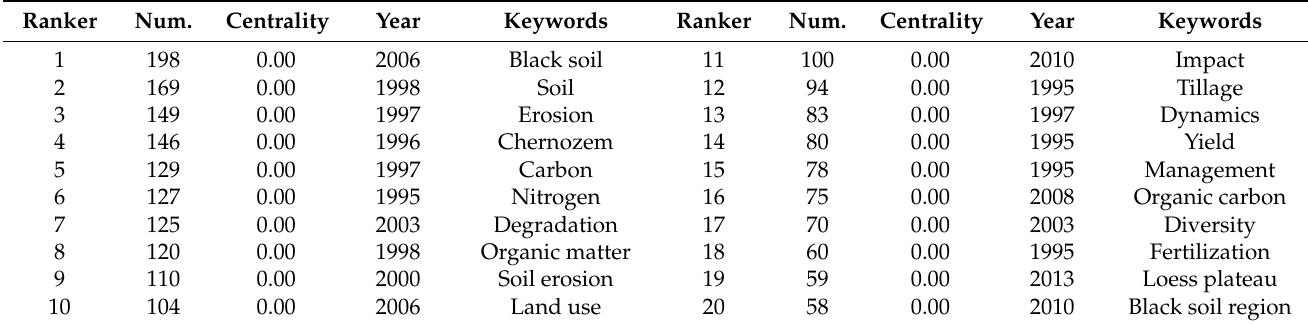
Table 4. Information on the top 20 keywords in terms of number of publications.